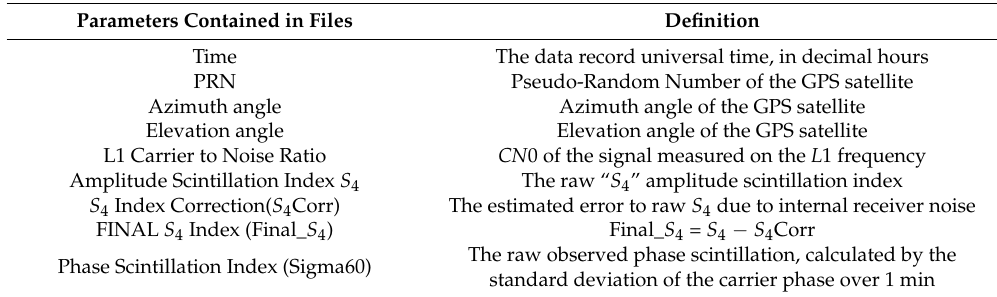
Table 1. The parameters provided by SWS GPS ISMs observation